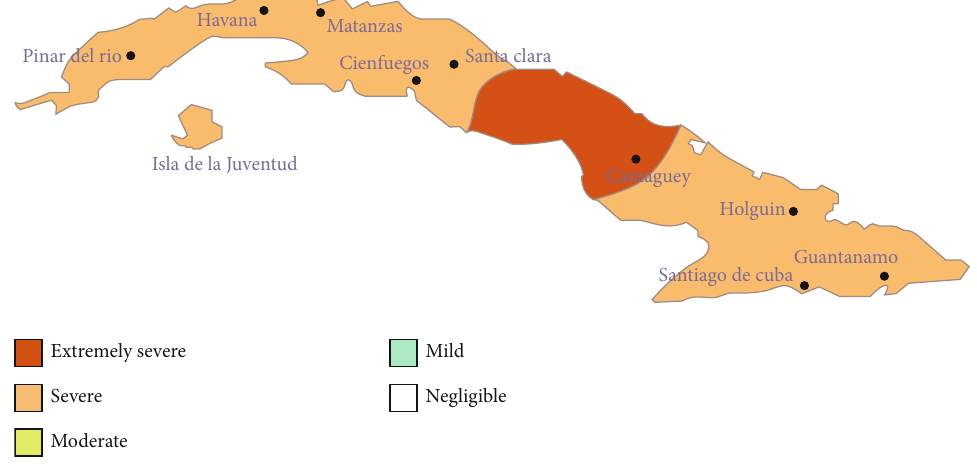
Figure 8: Atmospheric corrosion in Cuba [64].